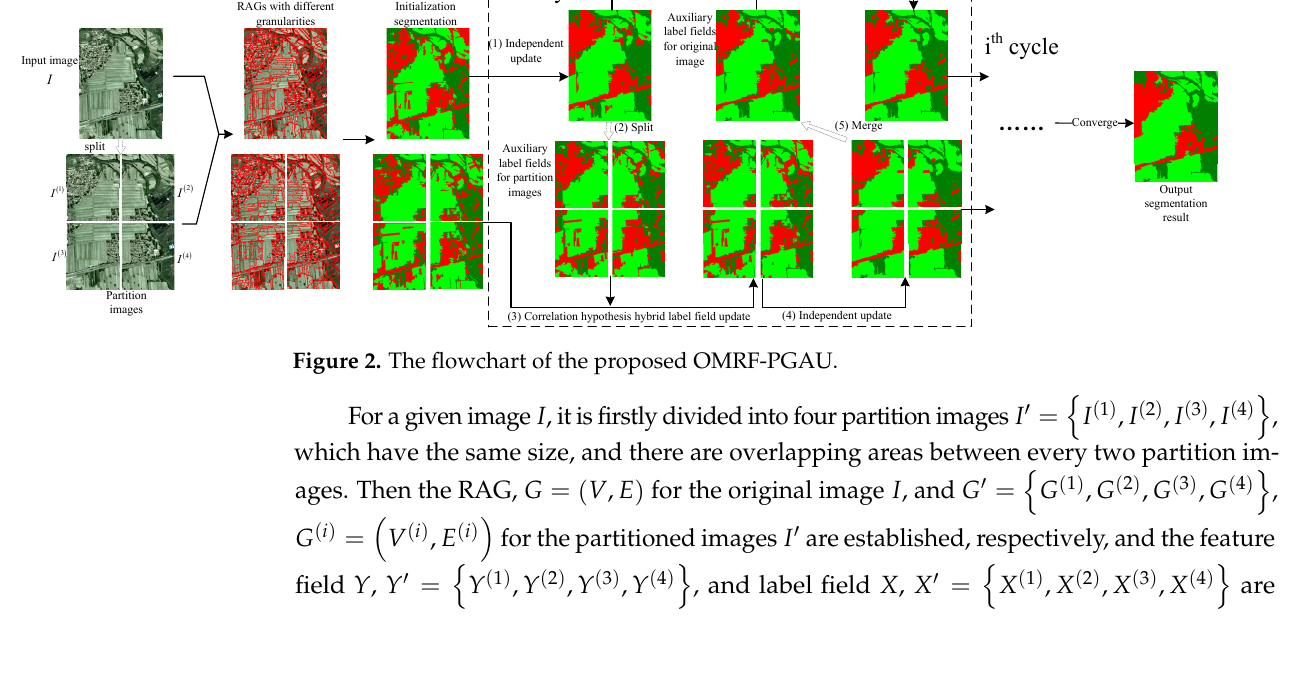
(cid:111) , and label field X , X (cid:48) =